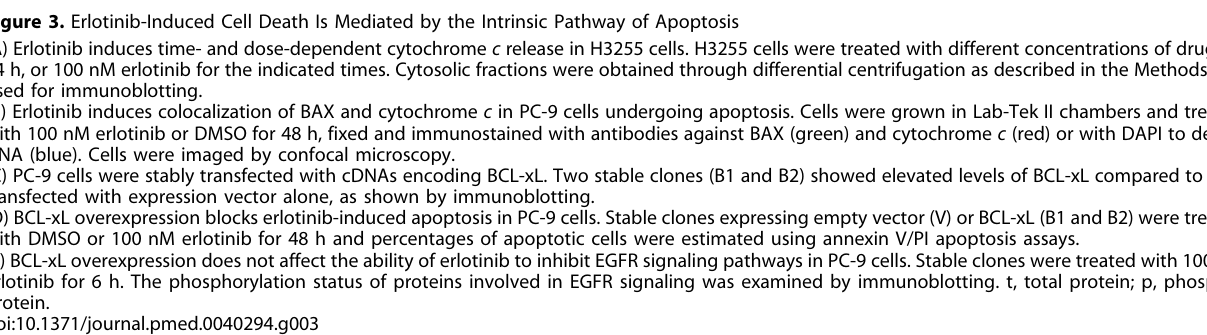
Figure 3. Erlotinib-Induced Cell Death Is Mediated by the Intrinsic Pathway of Apoptosis (A) Erlotinib induces time- and dose-dependent cytochrome c release in H3255 cells. H3255 cells were treated with different concentrations of drug for 24 h, or 100 nM erlotinib for the indicated times. Cytosolic fractions were obtained through differential centrifugation as described in the Methods and used for immunoblotting. (B) Erlotinib induces colocalization of BAX and cytochrome c in PC-9 cells undergoing apoptosis. Cells were grown in Lab-Tek II chambers and treated with 100 nM erlotinib or DMSO for 48 h, fixed and immunostained with antibodies against BAX (green) and cytochrome c (red) or with DAPI to detect DNA (blue). Cells were imaged by confocal microscopy. (C) PC-9 cells were stably transfected with cDNAs encoding BCL-xL. Two stable clones (B1 and B2) showed elevated levels of BCL-xL compared to cells transfected with expression vector alone, as shown by immunoblotting. (D) BCL-xL overexpression blocks erlotinib-induced apoptosis in PC-9 cells. Stable clones expressing empty vector (V) or BCL-xL (B1 and B2) were treated with DMSO or 100 nM erlotinib for 48 h and percentages of apoptotic cells were estimated using annexin V/PI apoptosis assays. (E) BCL-xL overexpression does not affect the ability of erlotinib to inhibit EGFR signaling pathways in PC-9 cells. Stable clones were treated with 100 nM erlotinib for 6 h. The phosphorylation status of proteins involved in EGFR signaling was examined by immunoblotting. t, total protein; p, phospho-